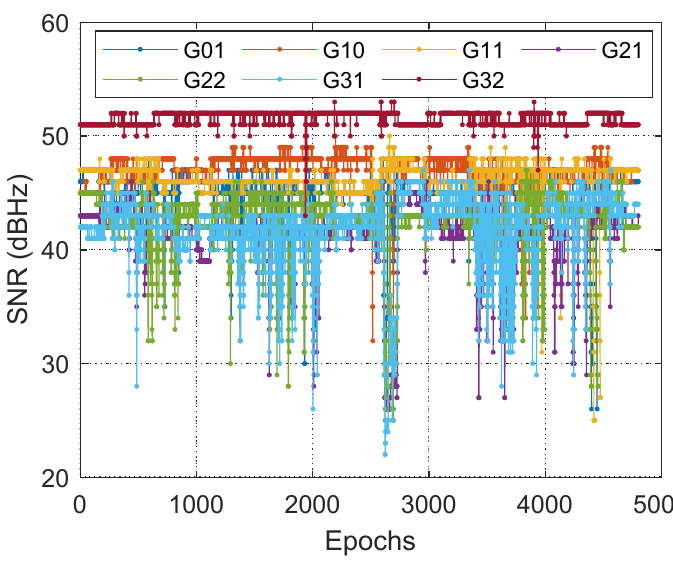
Figure 9. Signal-to-noise ratio (SNR) variations of the selected satellites.